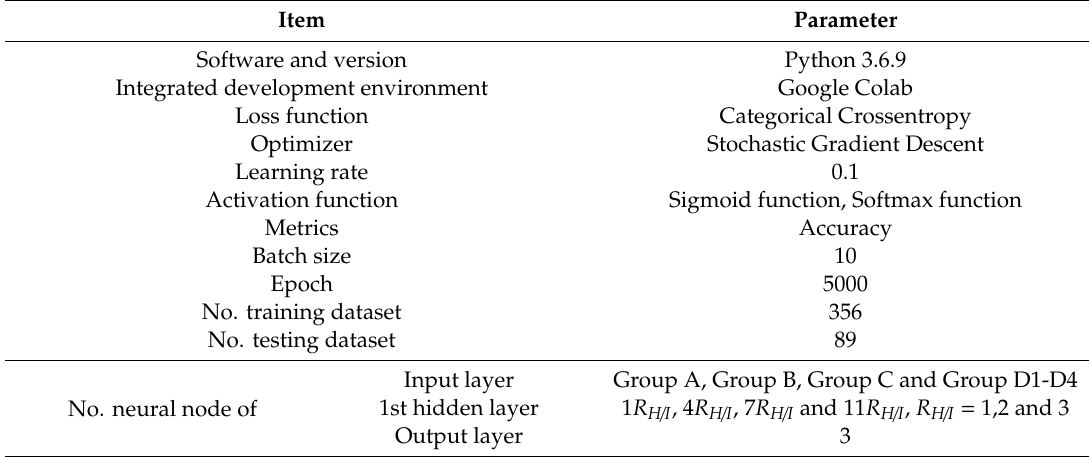
Table 4. Hyperparameters of the MLP